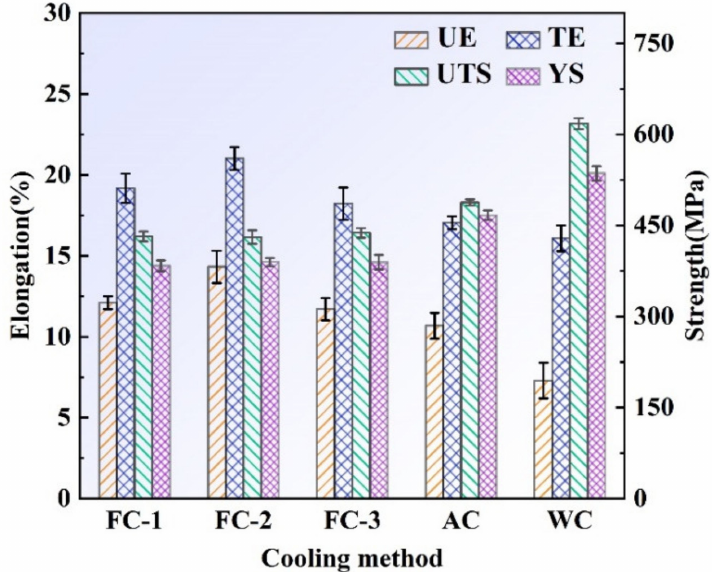
Figure 11. The variation of strength and elongation of Zr-4Hf-3Nb (wt%) alloy. with various cooling